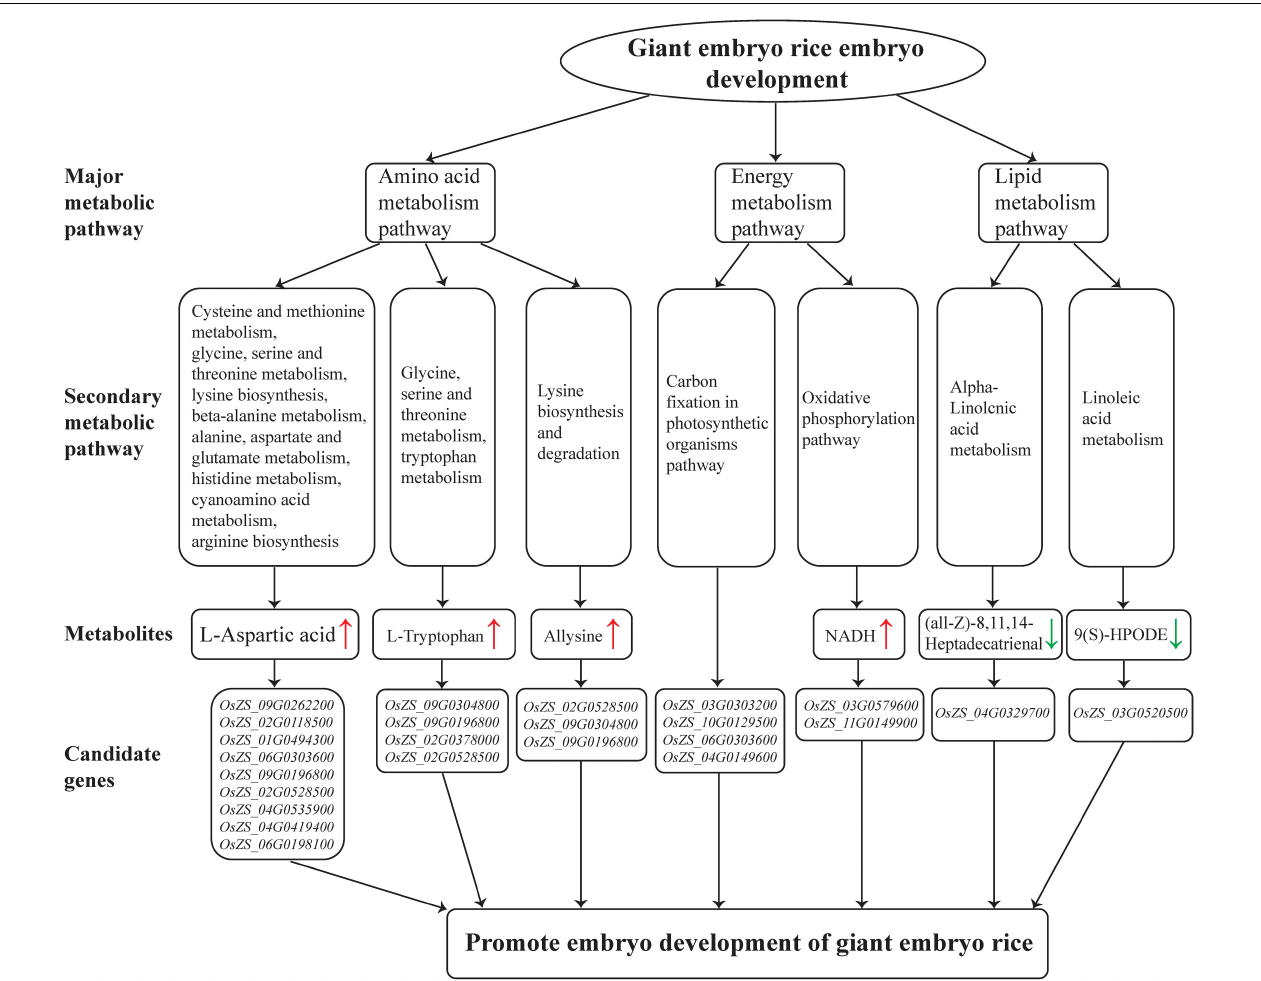
FIGURE 8 | Metabolic pathways involved in rice giant embryo development and candidate genes that regulate metabolites accumulation. Red and green arrows indicate increased metabolites and decreased metabolites,